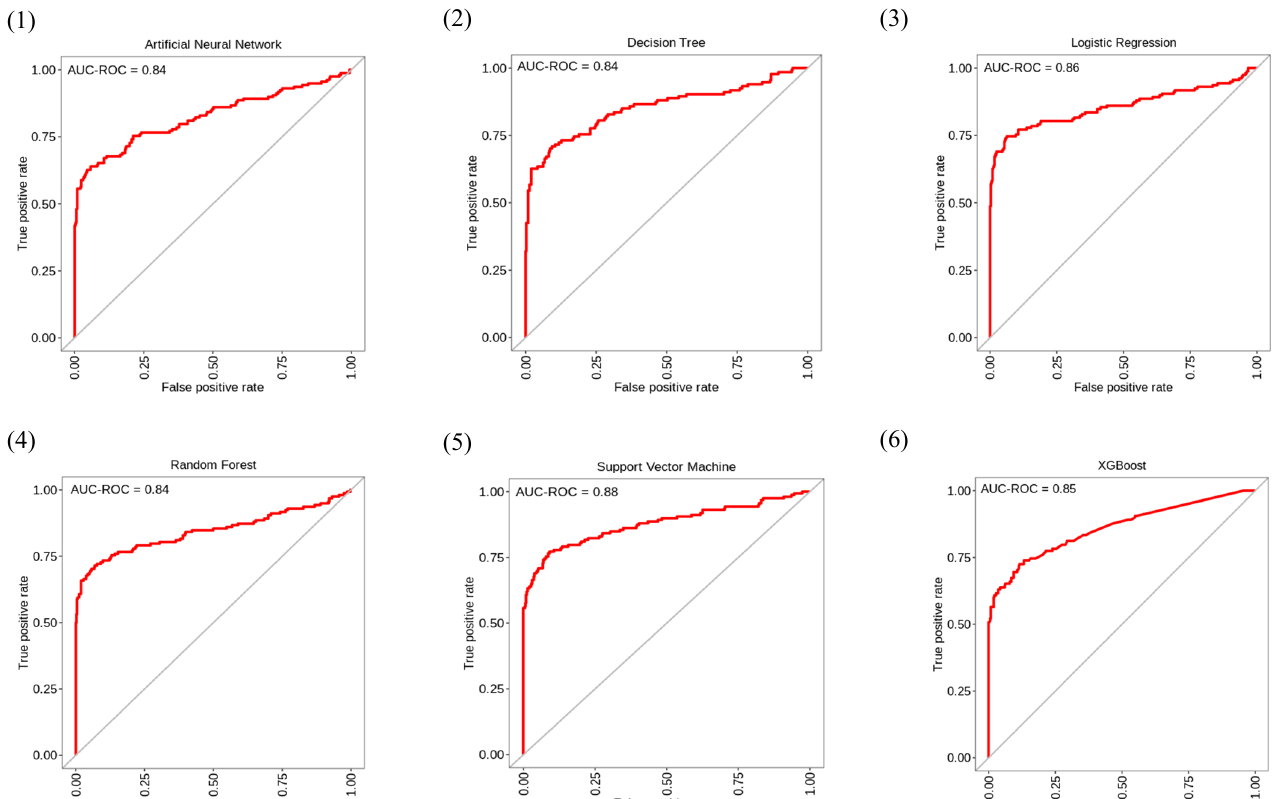
Figure 3. Receiver operating characteristic curves for each of the six machine learning methods. ROC-AUC of the six models [( 1 ) artificial neural network, ( 2 ) decision tree, ( 3 ) logistic regression, ( 4 ) random forest, ( 5 ) support vector machine, and ( 6 ) XGBoost] for predicting patient weaning within 24 h. ROC-AUC: Receiver operating characteristic curve area under the curve. Table 2. Performance comparisons of six machine learning methods.